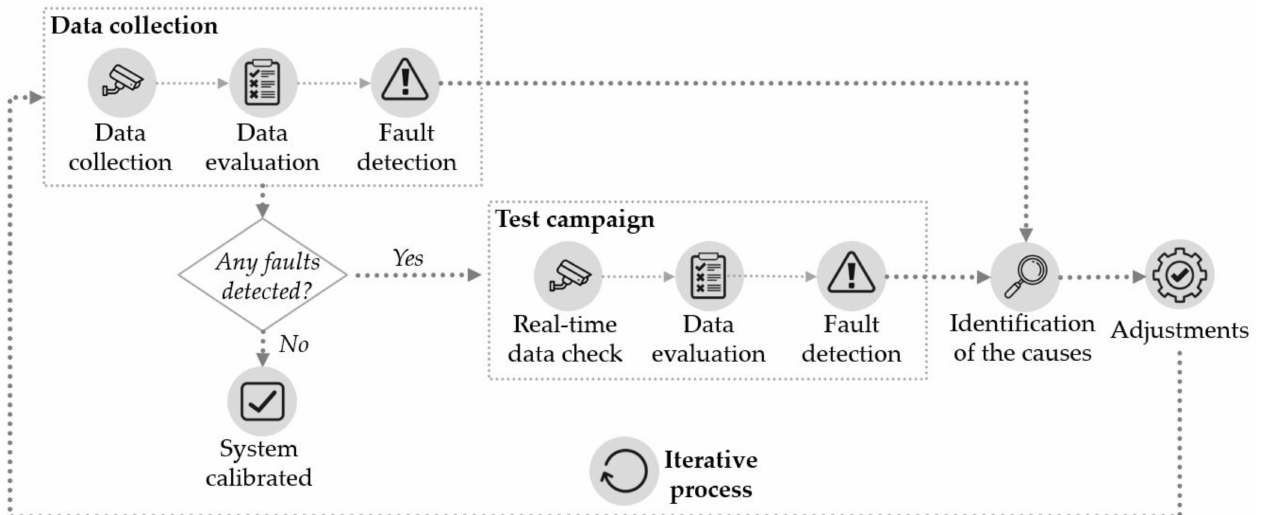
Figure 3. Data collection, test campaign, and adjustments application iterative